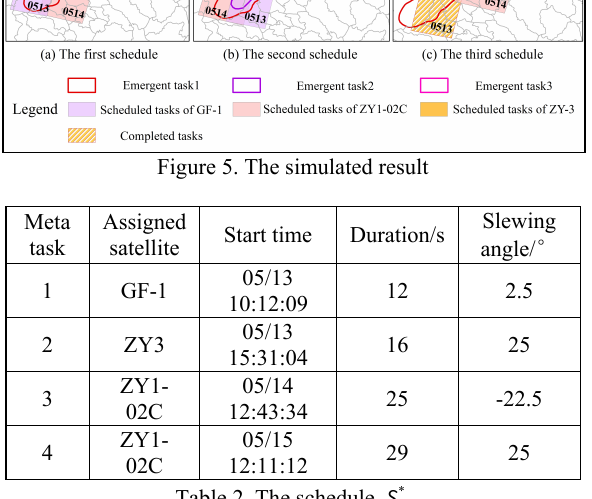
Table 2. The schedule *